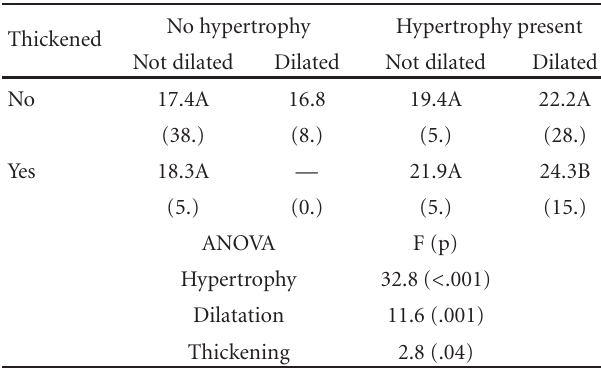
Table 2: Mean myocyte breadth ( μ m) according to LV hypertrophy, dilatation and wall thickening (numbers of cases in parentheses). ∗